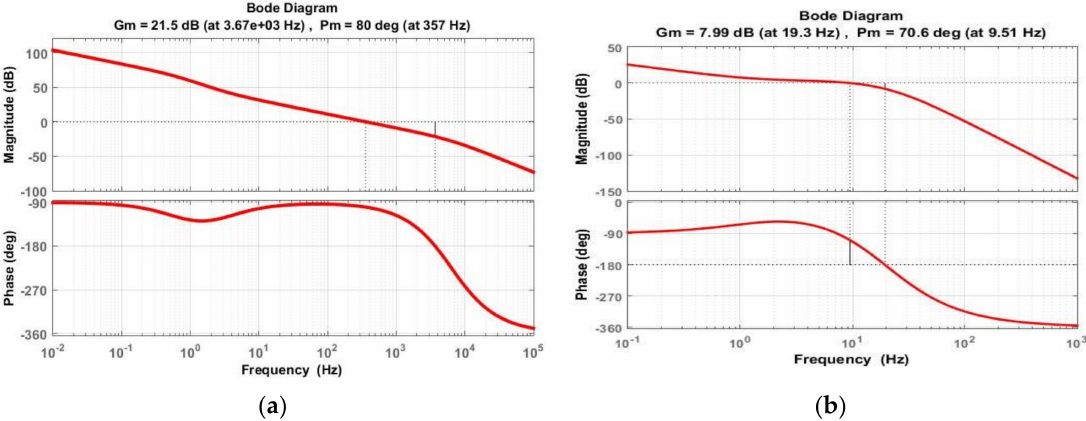
Figure 7. Open loop gain Bode plot of the ( a ) G ol (s) for the fundamental current controller ( b ) G olnh (s) for the nth har- monic